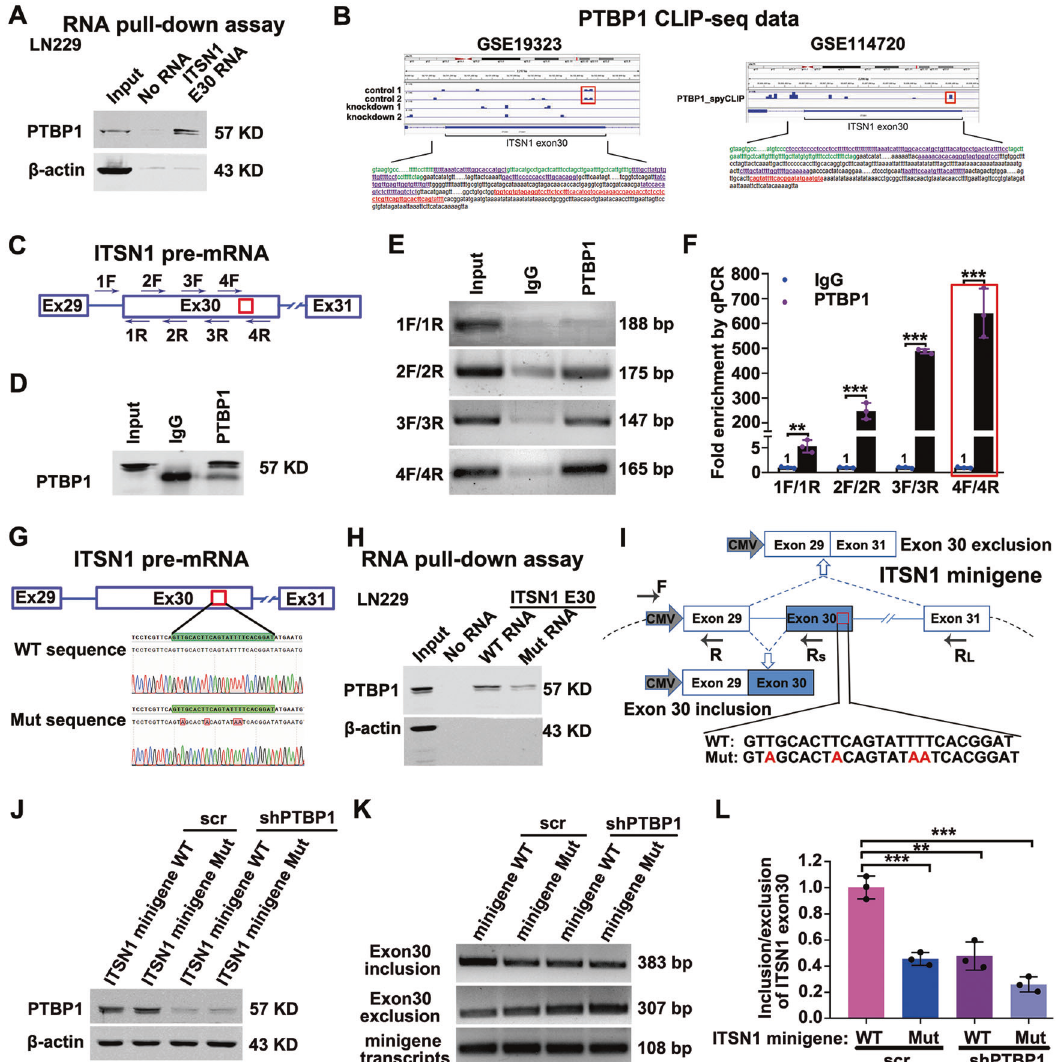
Fig. 4 PTBP1 bound exon 30 and adjacent intronic areas of ITSN1 RNA and modulated splicing of ITSN1. A In vitro RNA pull-down assay in LN229 cell line. Proteins were subjected to western blot analysis with anti-PTBP1 antibody after pull-down. B Analysis of PTBP1 CLIP-seq data from GSE19323 and GSE114720, the blue lane shows PTBP1 CLIP peaks for exon 30 and adjacent area of introns of ITSN1. C The primer position used to detect the binding segment of PTBP1 and ITSN1 pre-mRNA in the RIP experiment. D PTBP1 protein precipitation upon RIP with anti-PTBP1. E ITSN1 ampli fi cation from the anti-PTBP1 coprecipitated RNA fraction. F RIP with anti-PTBP1 followed by RT – qPCR quanti fi cation, values were expressed as mean ± SD from three independent experiments (two-tailed Student ’ s t test, ** P < 0.01, *** P < 0.001). G The potential binding sequences of PTBP1 within ITSN1 E30 RNA used in the RNA pulldown assay and its position in the ITSN1 pre-mRNA, the red font represented the mutated base. H RNA pulldown assay was used to detect the binding of PTBP1 to the biotinylated ITSN1 E30 WT RNA and ITSN1 mutant RNA. I Schematic representation of the ITSN1 minigene and the primer sets for PCR detection of ITSN1 exon 30- included and -excluded products. The primers for the internal reference of exogenous ITSN1-minigene were CMV-F and E29-R. The mutated base sequence of the ITSN1-minigene was marked with red font. J Western blot analysis for the inhibition of PTBP1 in transient cells transfected with the wild-type and mutant ITSN1-minigene plasmids. K Representative pictures of agarose PCR gels depicting the inversion in the splicing pattern of ITSN1 regulated by PTBP1 after transfected with the wild-type and mutant ITSN1-minigene plasmids. L RT – qPCR analysis showing changes in the ratio of ITSN1-S/ITSN1-L upon silencing PTBP1 in LN229 cells expressing ITSN1 minigene or ITSN1 mutant minigene. Values were expressed as mean ± SD from three independent experiments (two-tailed Student ’ s t test, *** P < the effect of silencing PTBP1 on the expression of ITSN1-S and in vivo. Stable cell lines with PTBP1 silencing or not were injected ITSN1-L. RT – qPCR results showed that silencing PTBP1 lowered the subcutaneously into nude mice and formed tumors (Fig. 5H). ratio of ITSN1-S/ITSN1-L signi fi cantly by increasing ITSN1-L as well Compared with control cells, tumors formed with PTBP1-silenced as decreasing ITSN1-S (Supplementary Fig. S4), which was cells grew signi fi cantly slower (Fig. 5I). Then xenograft tumors consistent with the in vitro results. HE staining was applied in were dissected 7 weeks post-inoculation. On gross inspection, the xenograft paraf fi n specimens and frequency of xenograft invasion tumors formed by PTBP1 knockdown LN229 cells were markedly was counted and determined. Notably, the expression level of smaller compared with those formed by control cells (Fig. 5J). And PTBP1 was signi fi cantly positively correlated with tumor cell total RNA was extracted from xenograft tumor tissues to detect